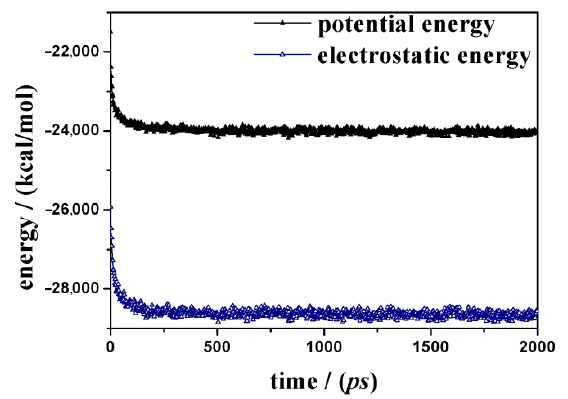
Figure 5. Potential energy (line and symbols in black) and electrostatic energy (line and symbols in blue) calculated as a function of the MD run time starting from 28 ketoprofen drug molecules in racemic mixture on hydrated amorphous SiO 2 surface are shown.